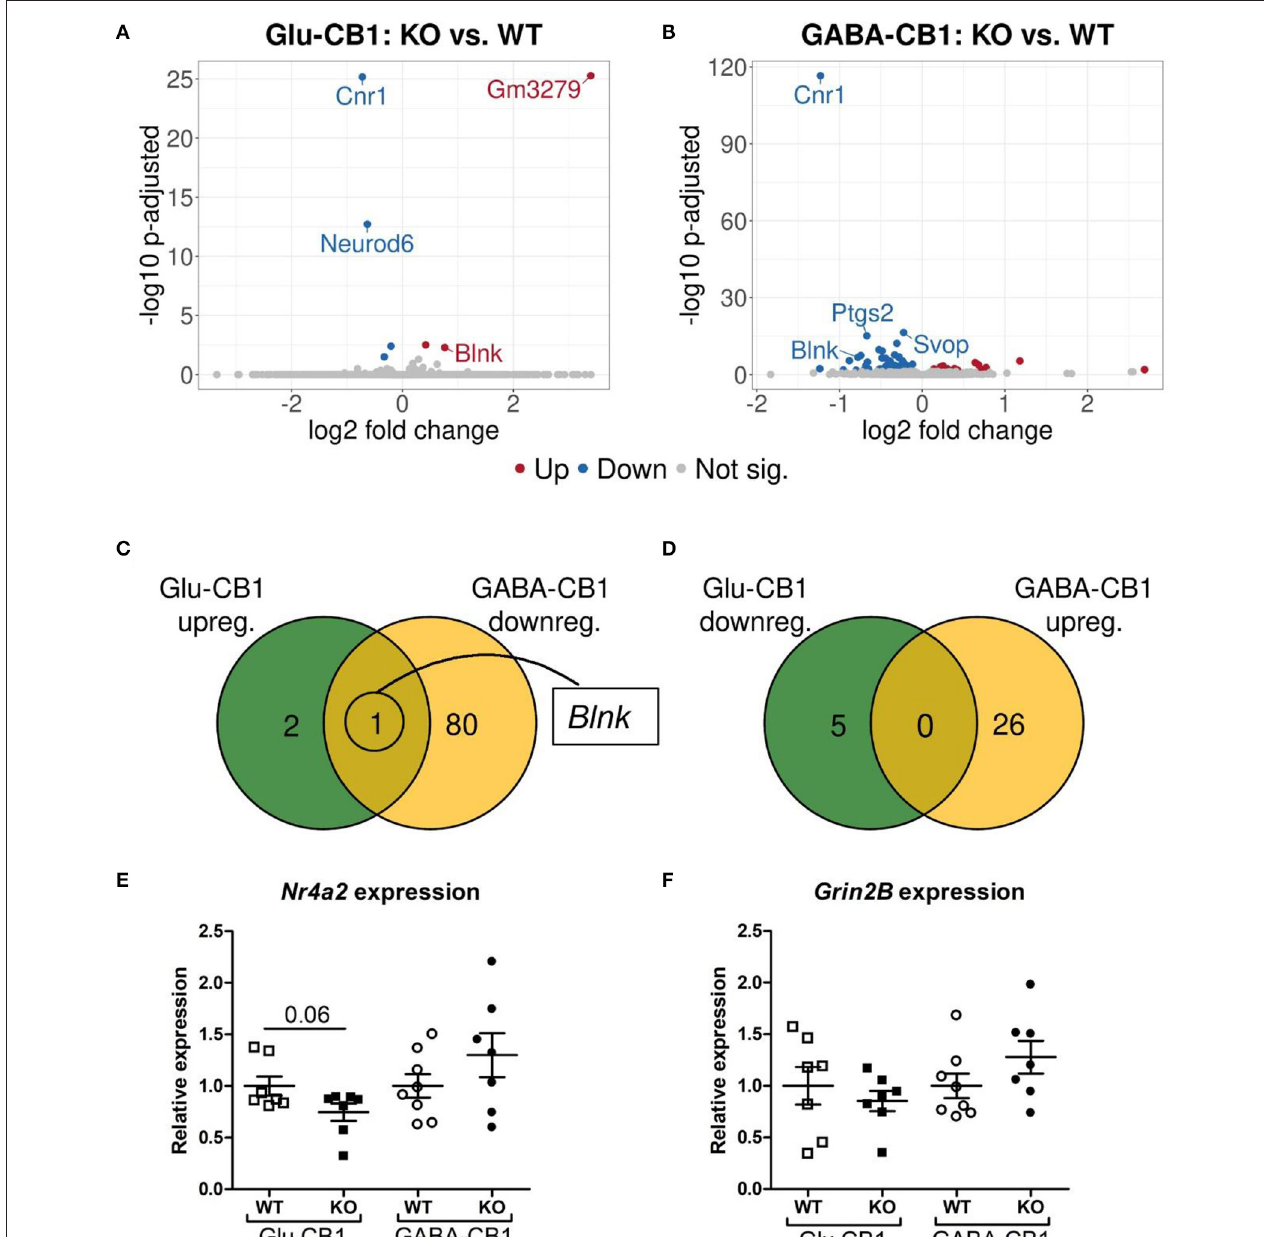
FIGURE 2 | Transcriptomic profiles from Glu-CB1-KO and GABA-CB1-KO mice in the basal state. (A,B) Volcano plots showing differentially expressed genes (red and blue dots) found when comparing Glu-CB1-KO (A) and GABA-CB1-KO (B) mice to their respective CB1-WT in their basal state. Red dots represent upregulated genes resulting from this comparison, whereas blue dots indicate downregulated genes. Labels of the top3, dichotomic, and qPCR-validated DEGs are shown. Non-significant genes are colored in gray. (C,D) Venn diagrams to visualize the number of dichotomic genes found between Glu-CB1 and GABA-CB1 DEGs in the basal state, i.e., those genes that appear up-regulated in one of the conditional CB1-KO lines and down-regulated in the other, or vice versa. (E) Expression levels derived from qPCR of the transcription factor Nr4a2 for each of the genotypes analyzed in the basal state. (F) Expression levels derived from qPCR of the gene Grin2B for each of the genotypes analyzed in the basal state. RT-qPCR data normalized to β -actin . Bars represent mean ± SEM. Unpaired t-Test with Welch’s correction when variances between groups were